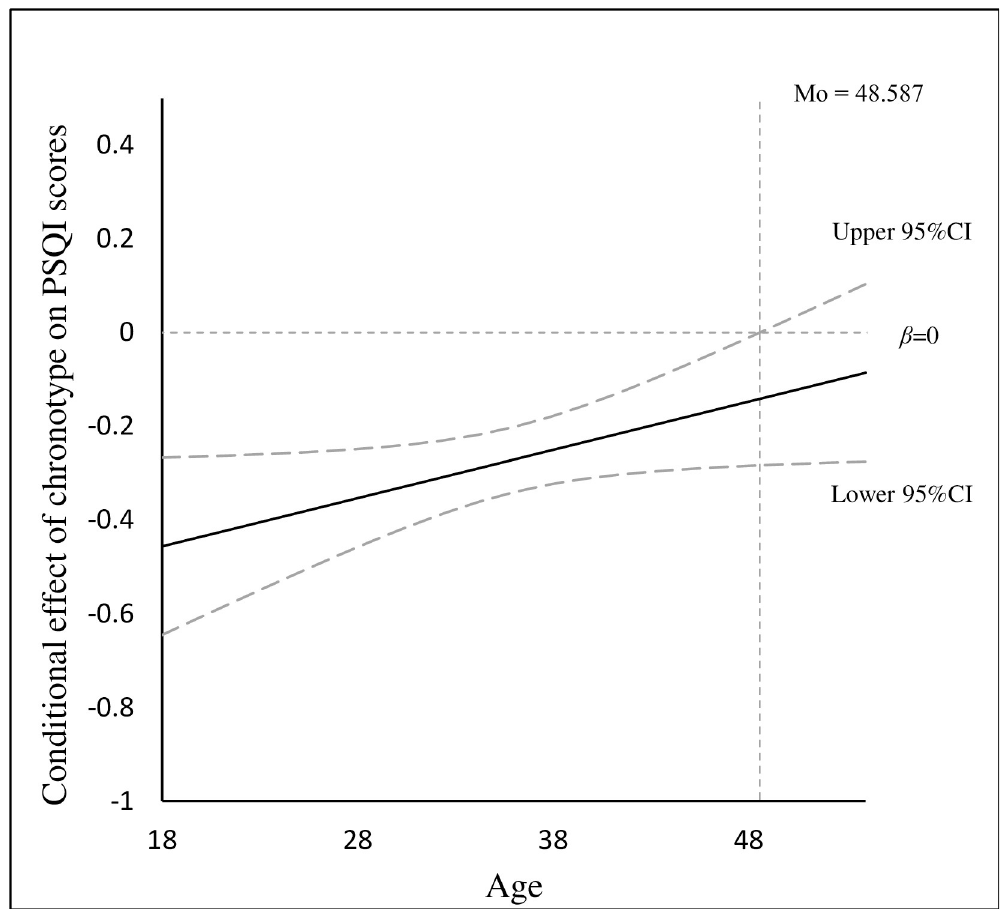
Fig 2. The conditional effect of chronotype on PSQI